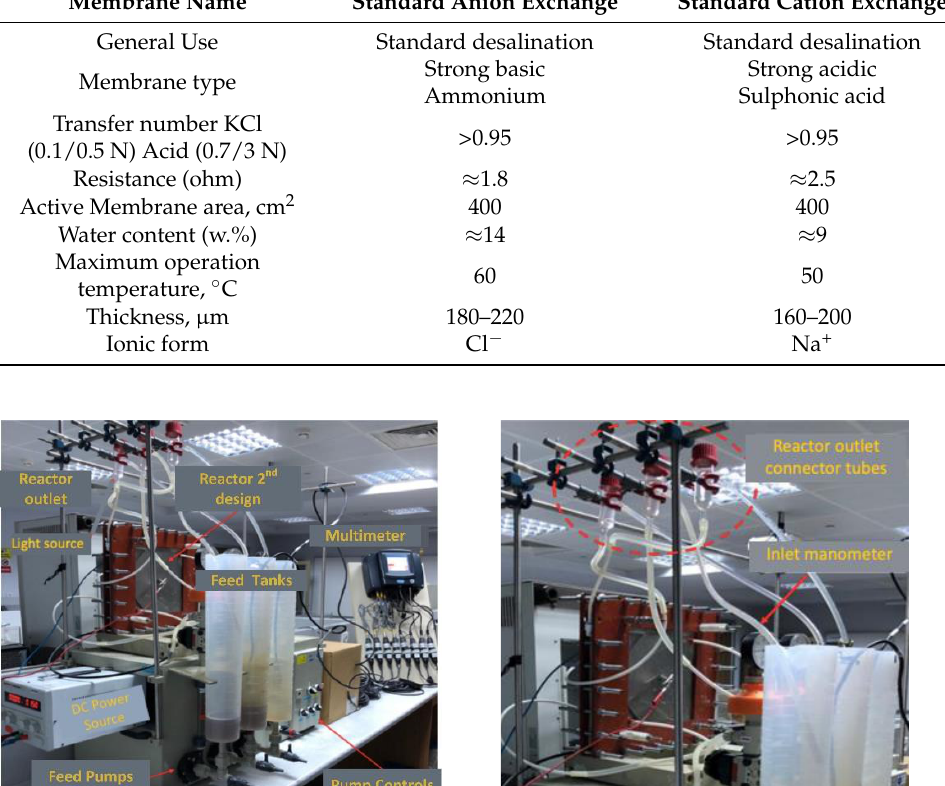
Table 2. Characteristics of anion and cation exchange membranes.